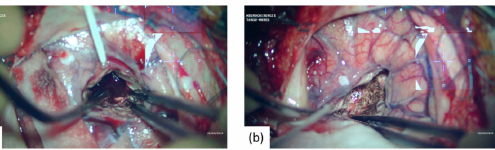
Figure 3. Microsurgical intraoperative aspects showing: ( a ) approach and initial aspect of the ICH; ( b ) after the ICH evacuation.